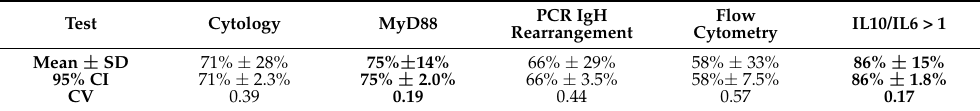
Table 2. Unweighted aggregate data of the different tests. The two highest mean and confidence interval as well as the lowest coefficient of variation values are highlighted with bold. Test Cytology